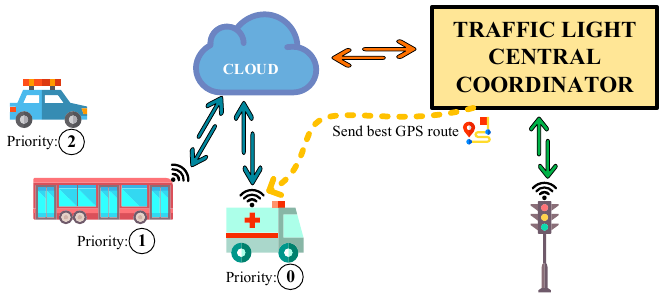
4 of 18 Figure 1. ZigBee mesh. 3.2. Protocol and Security ZigBee implements several complex security measures to ensure secure network communication. ZigBee implements the security measures of IEEE 802.15.4, including access control, message integrity, message confidentiality, and replay protection [41], which adds extra security layers to the Network and Application layers. The ZigBee security measures rely on an Advanced Encryption Standard (AES) 128b encryption algorithm that is deployed with a master key pre-installed in the device. This is a link key managed by the Application layer that is unique between two nodes, and a unique 128b key that is shared among all nodes in a ZigBee network [42]. A 128-bit link key is shared by two devices to secure the communication between them. To broadcast communications, all the devices share a 128-bit network key. Link keys are acquired via key-transport, key-establishment, or pre-instalment [43]. The CP is based on a framework consisting of five fields: the start delimiter, the frame length, and the frame data portion, which is composed of the Application Programming Interface (API) identifier and specific data, the contents of the specific data that change according to the API identifier, and, lastly, the checksum, which is a byte containing the hash sum of the API frame bytes. Each sender receives feedback from each device for transmission confirmation. An encrypted password is used to protect any relevant information at the information processing level [33,34,44]. One of the main difficulties in the traffic flow near the crossroad points is when some priority vehicle needs to pass through a red light [45,46]. In these situations, the cars at the front of the line usually pass the red light without permission and move to other lanes to let priority one flow through the traffic queue. One solution for this problem is presented in this work. When a priority vehicle is in an emergency state, an onboard controller communicates with the cloud, coordinating